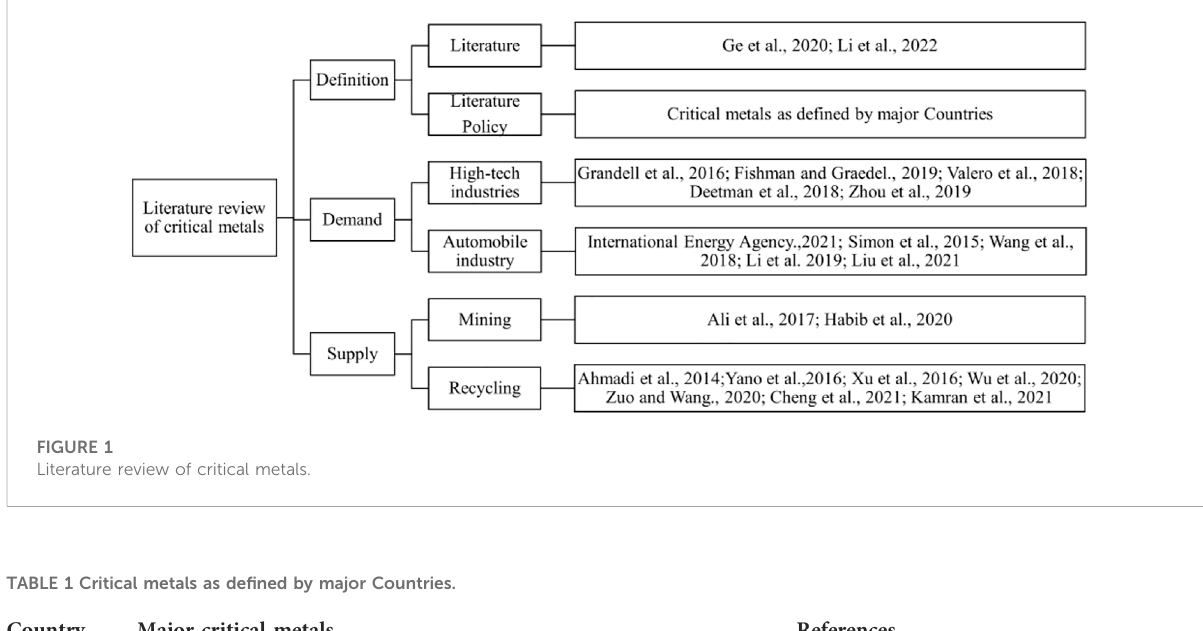
TABLE 1 Critical metals as de fi ned by major